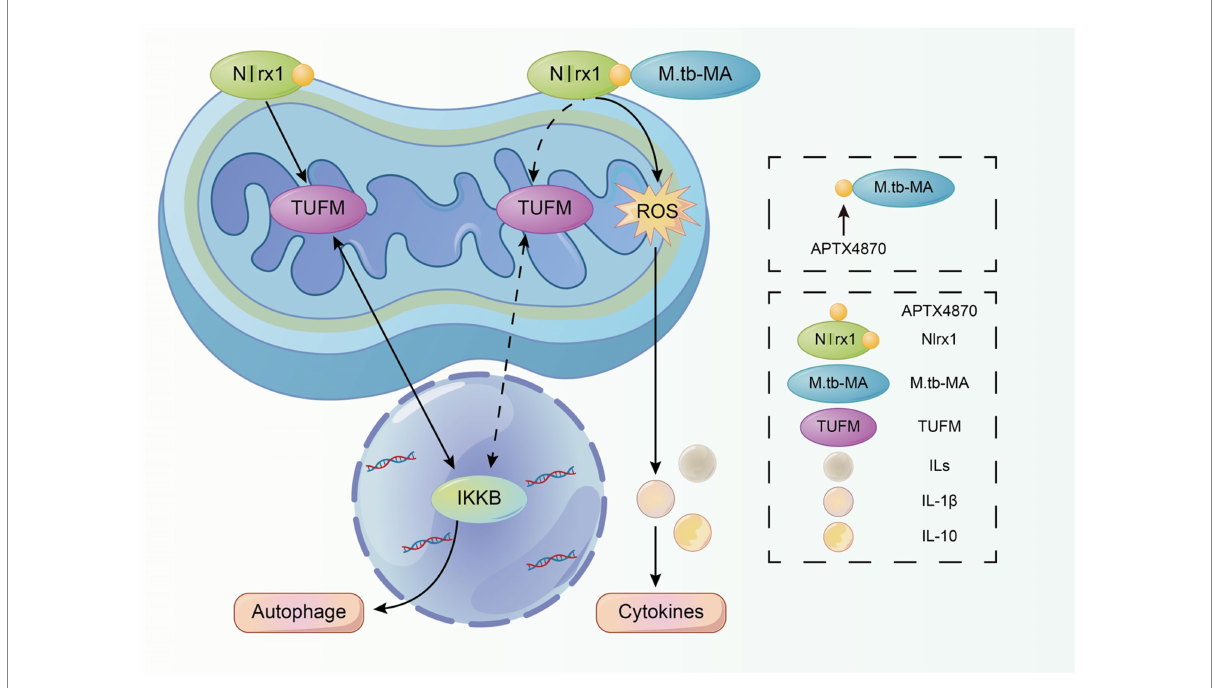
FIGURE 8 Schematic diagram of the mechanism of